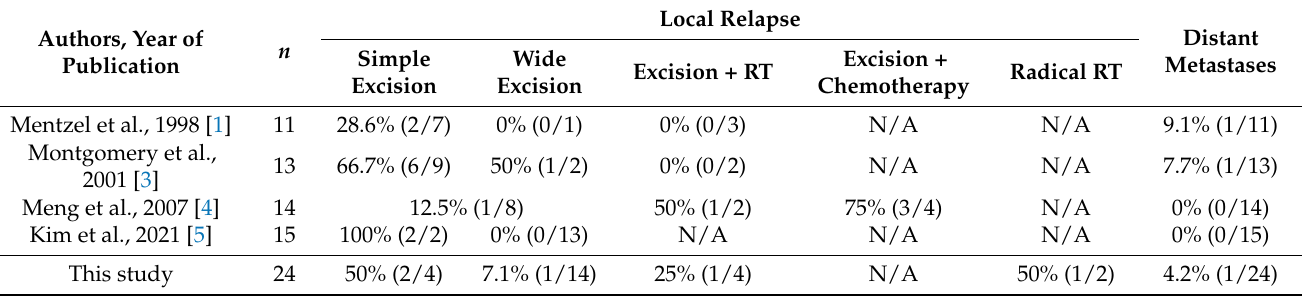
Table 5. Summary of local relapse and distant metastases of LGMS in previous reports and this